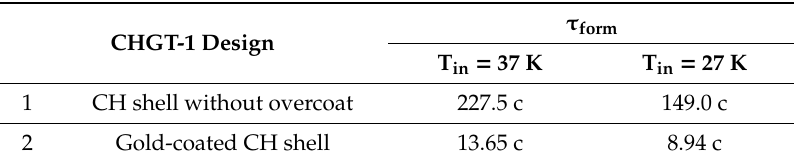
Table 1. FST layering time for classical high gain target (CHGT-1).